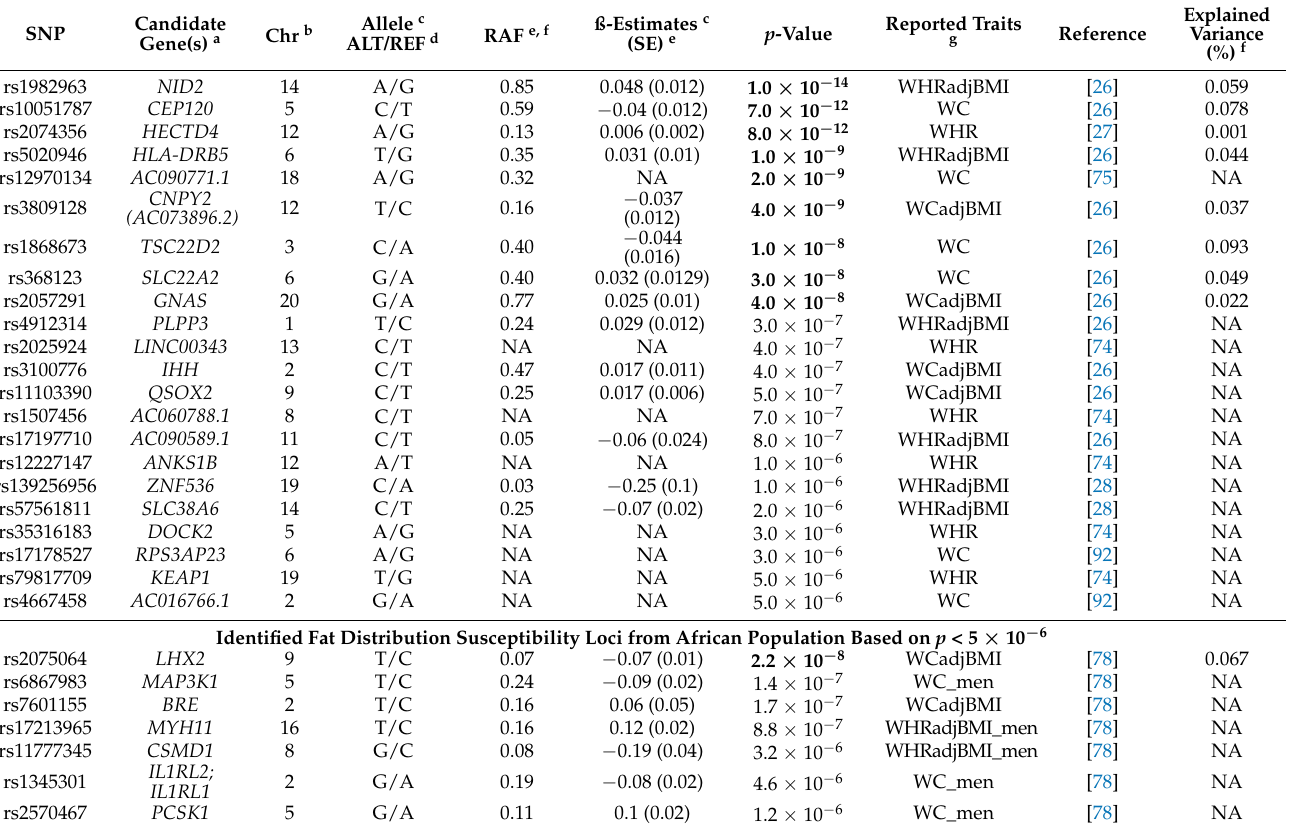
Table 3. Fat distribution traits susceptibility loci identified ( p < 5.0 × 10 − 6 ) in cohorts of Asian and African